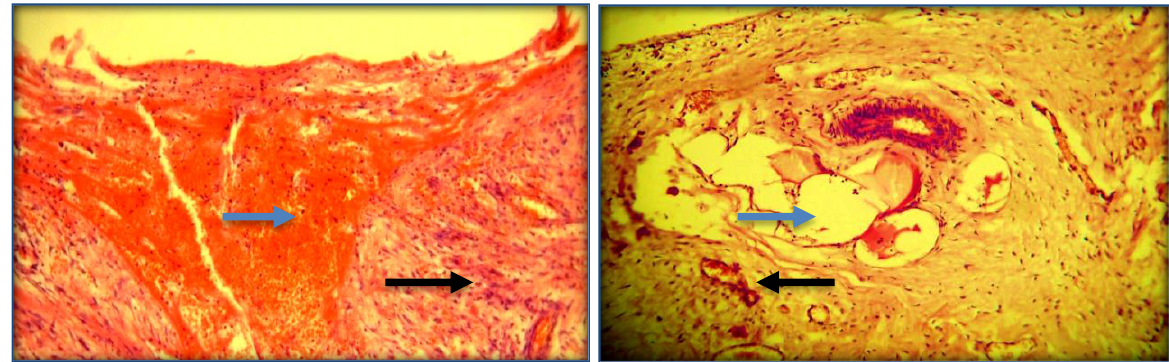
Figure, 6: Dog urinary bladder closed by inverting pattern, 3 days post-surgery show's, severe hemorrhage covering the surgical region and extend deeply to the muscular layer (black arrow), infiltrated with neutrophils (blue arrow) (H&E., 10X).